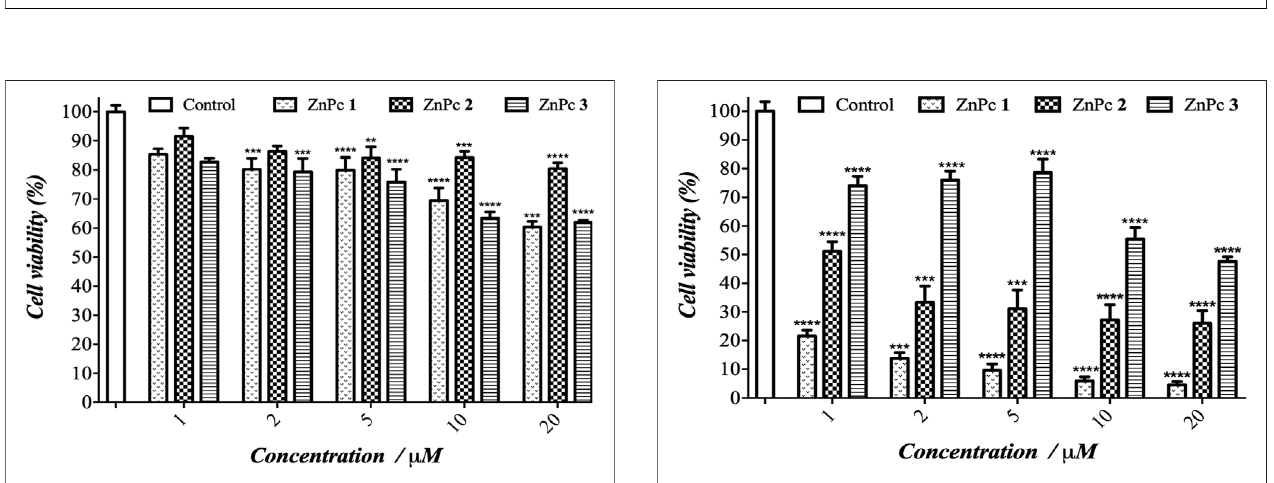
FIGURE 2 | (A) Emission spectra resolved direct detection of 1 O 2 species and (B) time-resolved direct detection of 1 O 2 species generated by ZnPc reference and ZnPcs 1 – 3.